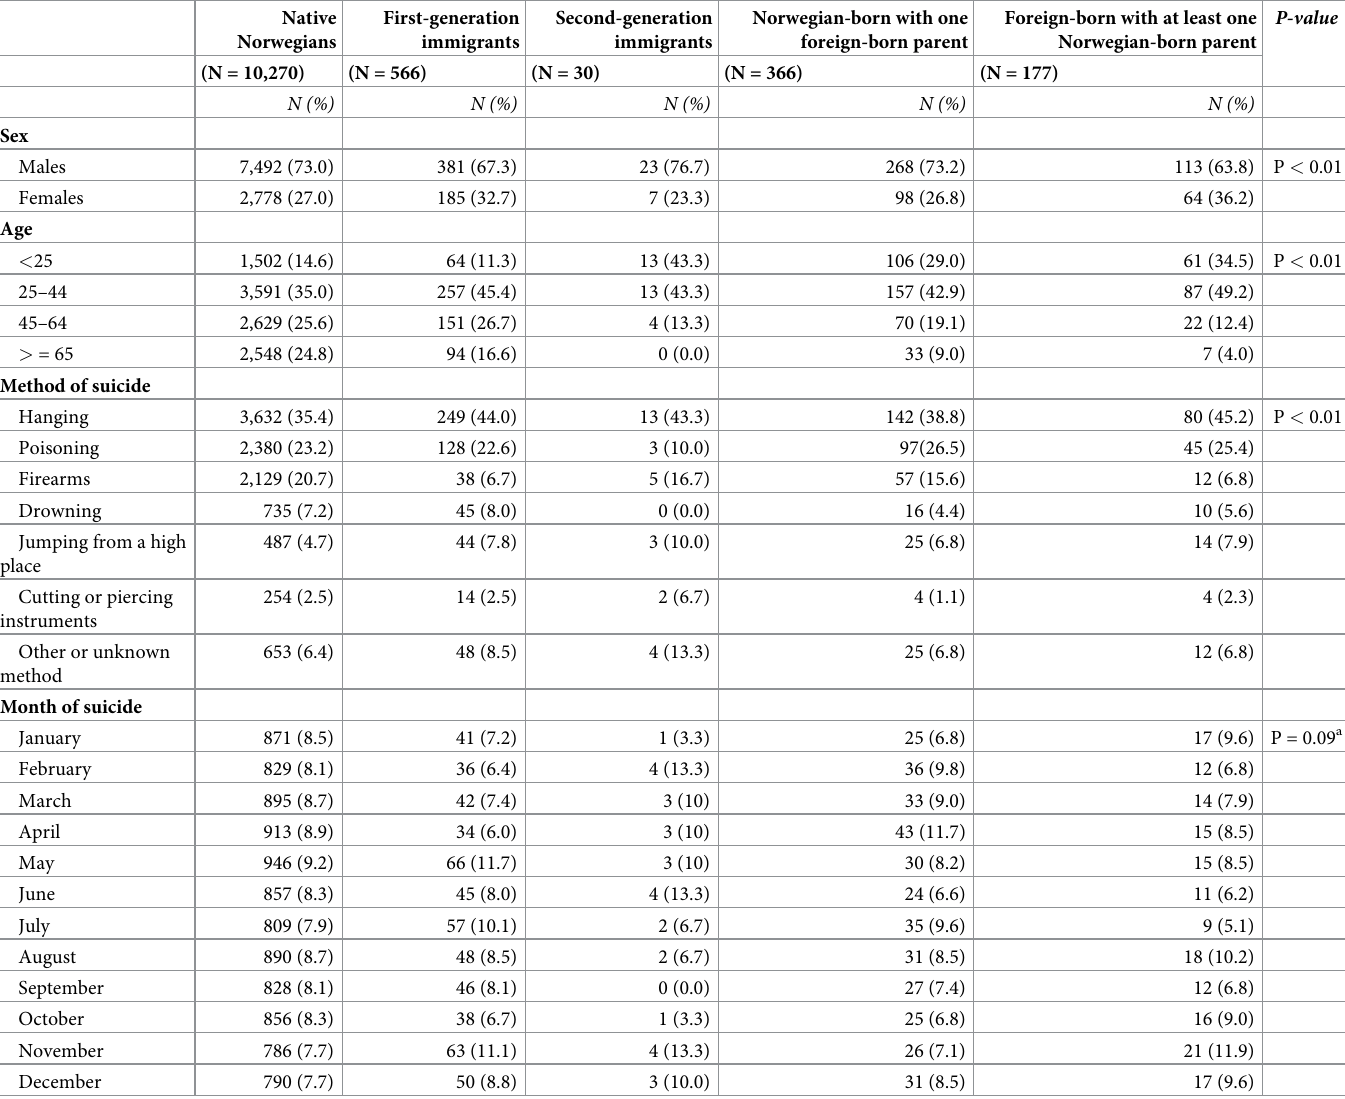
Table 2. Characteristics of suicide cases by immigration background with respect to sex, age, method of suicide, and month of suicide, 1992–2012. Native First-generation Second-generation Norwegian-born with one Foreign-born with at least one Norwegians immigrants immigrants foreign-born parent Norwegian-born parent